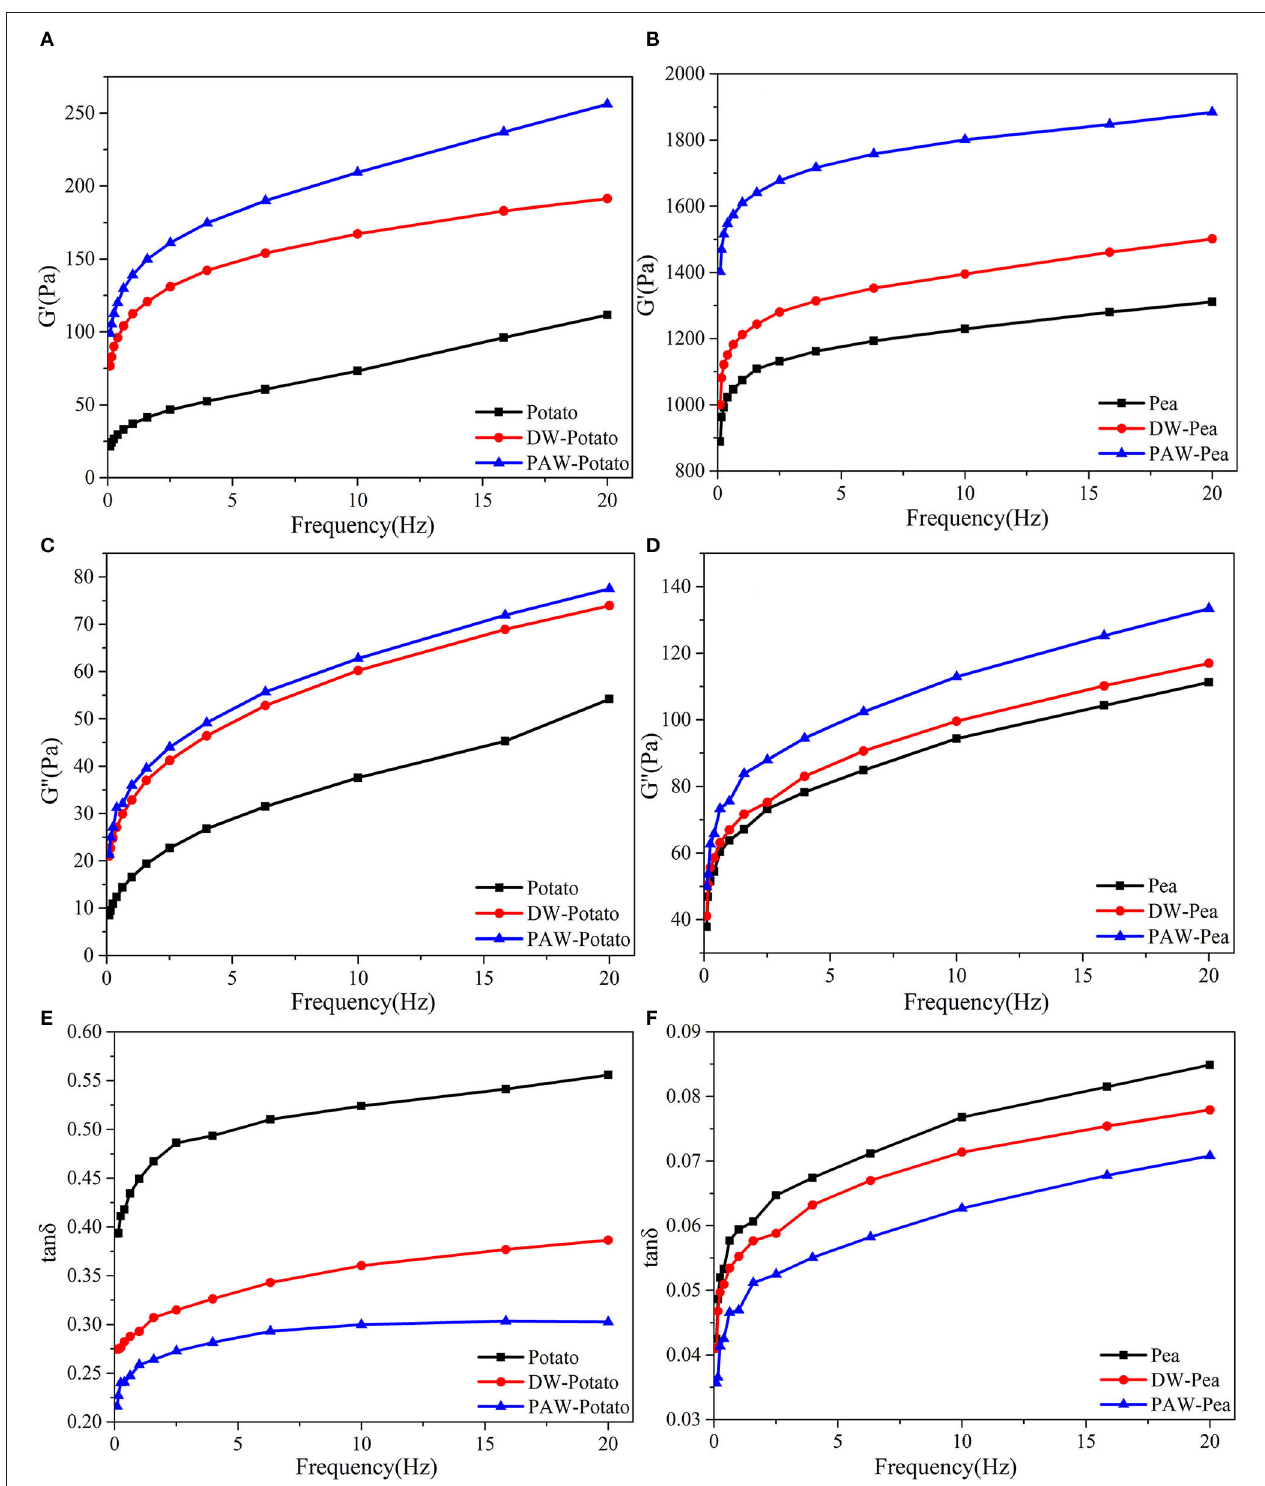
FIGURE 7 | Dynamic rheological curves of native and modified starches. (A) Storage modulus (G ′ ) of native, DW-ANN treated, and PAW-ANN treated potato starch. (B) Storage modulus (G ′ ) of native, DW-ANN treated, and PAW-ANN treated pea starch. (C) Loss modulus (G ′′ ) of native, DW-ANN treated, and PAW-ANN treated potato starch. (D) Loss modulus (G ′′ ) of native, DW-ANN treated, and PAW-ANN treated pea starch. (E) loss tangent (tan δ ) of native, DW-ANN treated, and PAW-ANN treated potato starch. (F) Loss tangent (tan δ ) of native, DW-ANN treated, and PAW-ANN treated pea starch.